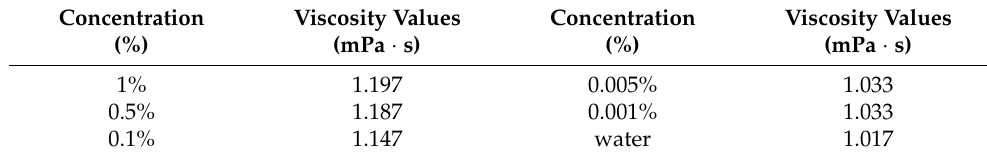
Table 3. The roughness factors for different leaf types.